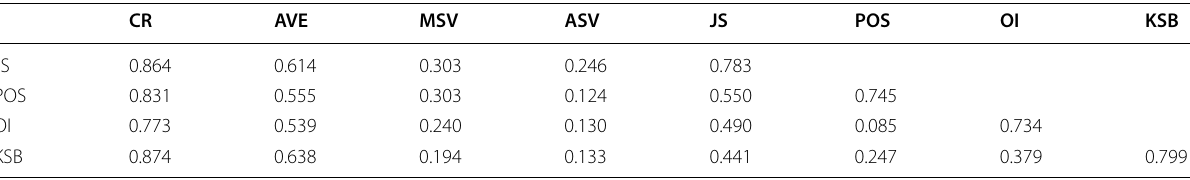
Table 5 Discriminant validity analysis